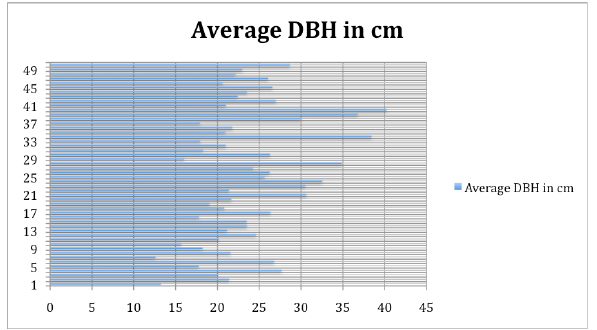
Figure 4: Average DBH in cm of the 50 sample grids The corresponding 27 LiDAR parameters of the 50 grids were then derived using Lastools. Using the automated least squares analysis, with the 27 parameters and measured DBH of each grid as input, an estimated DBH and coefficient of parameters for estimation were obtained. Using all the parameters, the generated DBH estimates have an r-squared of 0.71, AIC of 170.13 and BIC of 221. 75.